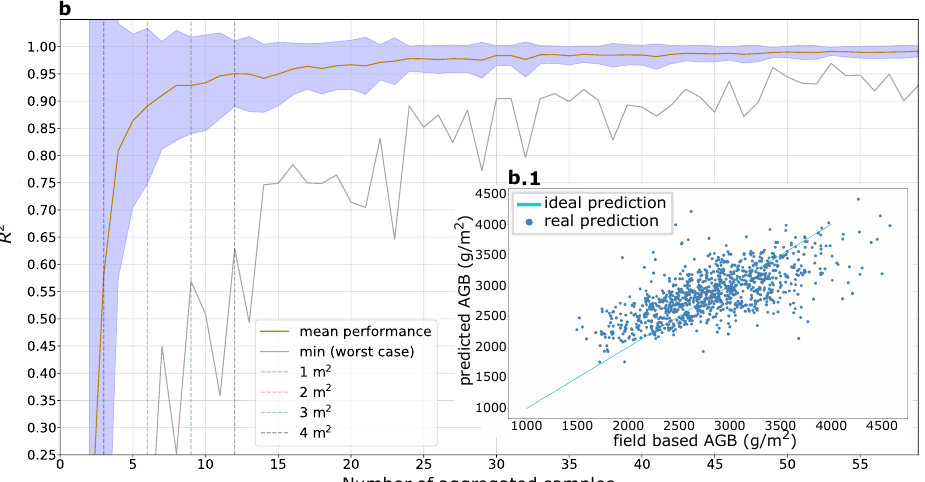
Figure 13. An analysis of the aggregated predictions using the wheat testing dataset: ( a ) the residual distribution had a mean value approaching zero with a slight overestimation (i.e., − 18.5 g/m 2 in the testing set, where N = 183), which represented a systematic error of 2% for the average wheat sample weight; ( b ) the R 2 score converged to 1 as the number of aggregated samples increased. At every step along the x -axis, the data series took the mean (green solid line) of 100 executions (at a 1 m 2 spatial resolution, where R 2 = 0.58). The light gray line shows the worst performance in each iteration, while the shaded area covers the confidence interval (i.e., ± the standard deviation); ( b.1 ) a scatter plot of the predicted AGB values vs. the AGB field measurements at a 1 m 2 spatial